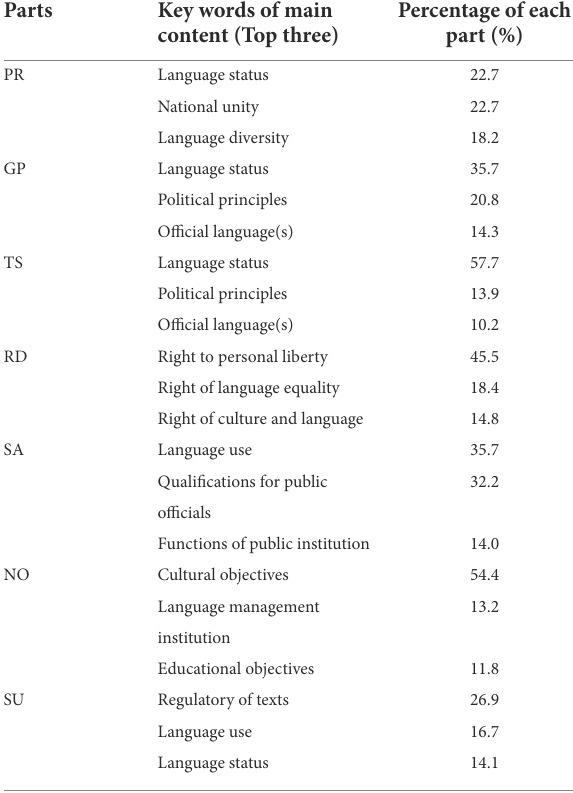
TABLE 4 The main content of each part and its percentage. Key words of main content (Top